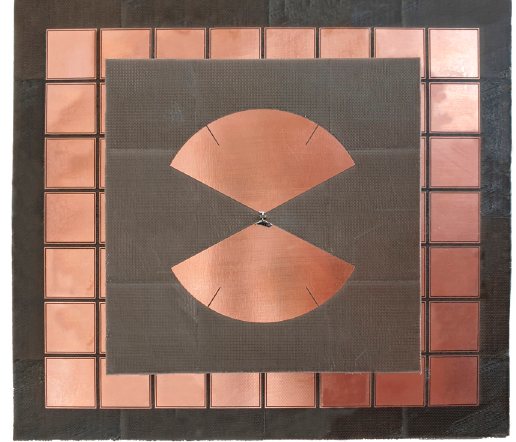
Figure 15. Realized antenna with AMC and balun.